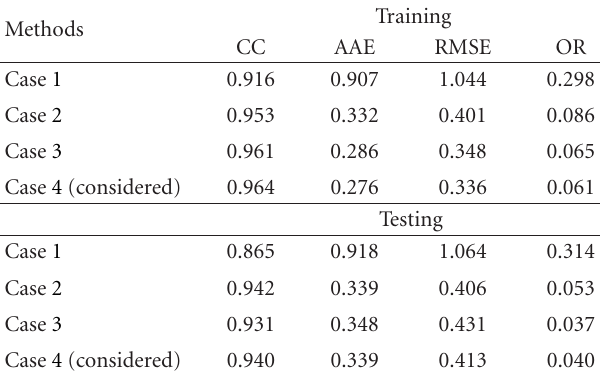
Table 1: Evaluation results on di ff erent features combined equa- tions with disparity.